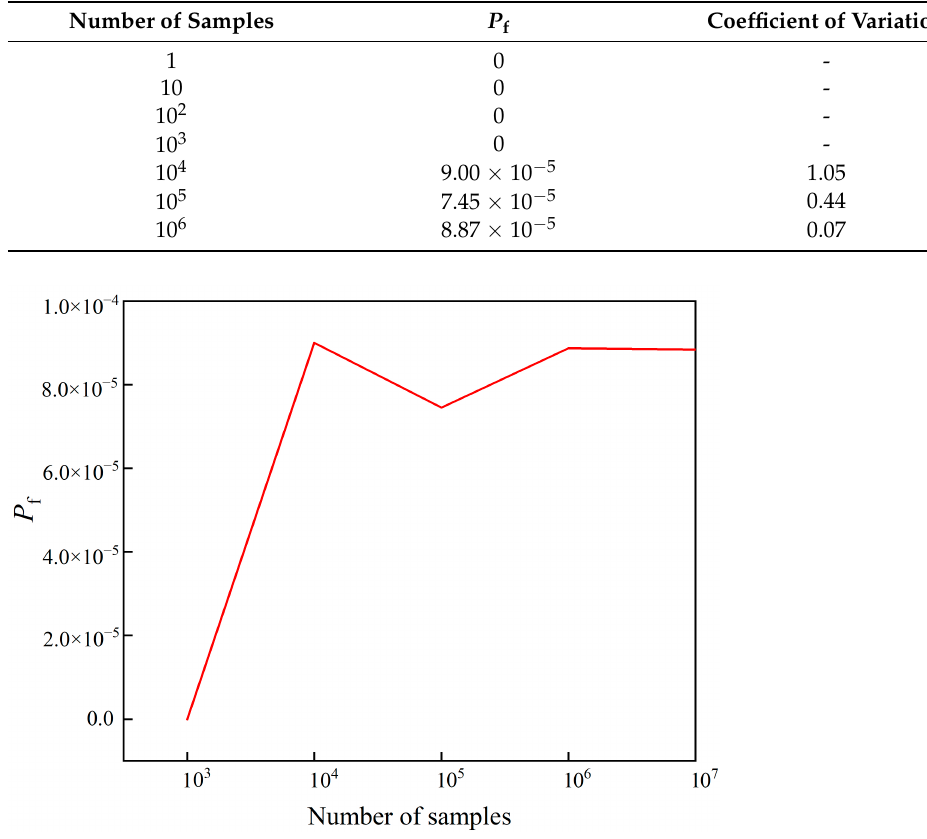
Table 6. Calculation results of the probability of stress exceedance at the toe of the dam.